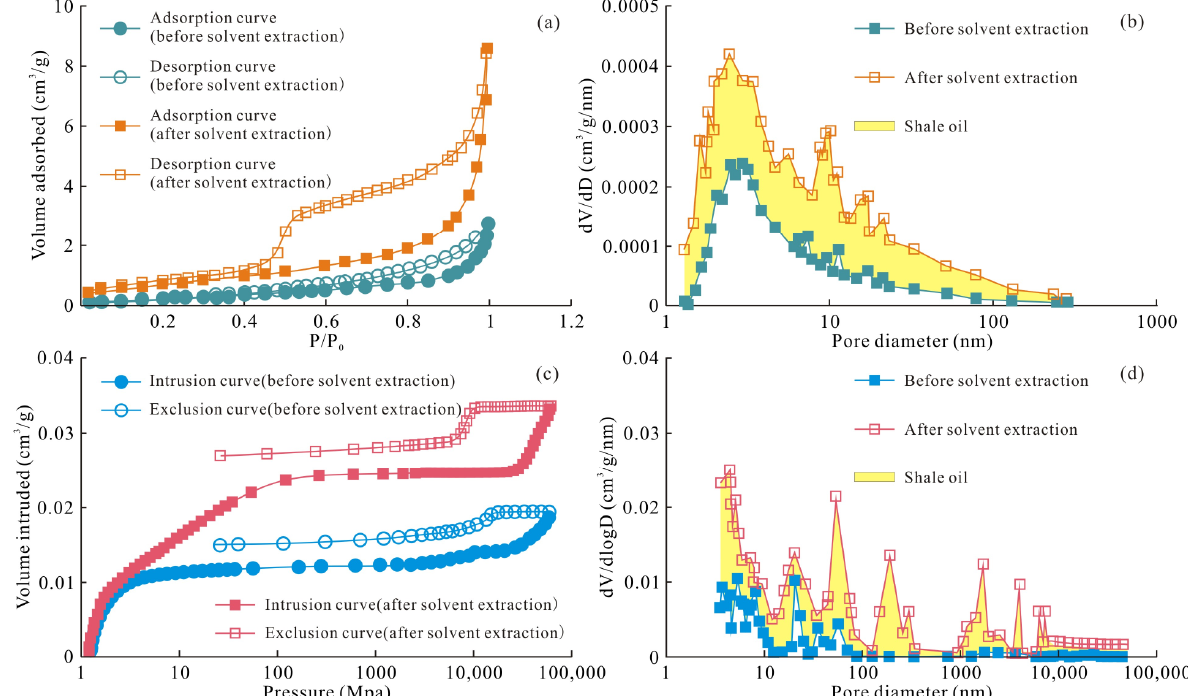
Figure 9. Experiment results and pore diameter distributions of low-temperature nitrogen physisorption and mercury intrusion porosimetry before and after solvent extraction of the Ek 2 shales in the Cangdong Sag. ( a , b ) Results from low-temperature nitrogen physisorption. ( c , d ) Results from mercury intrusion porosimetry.